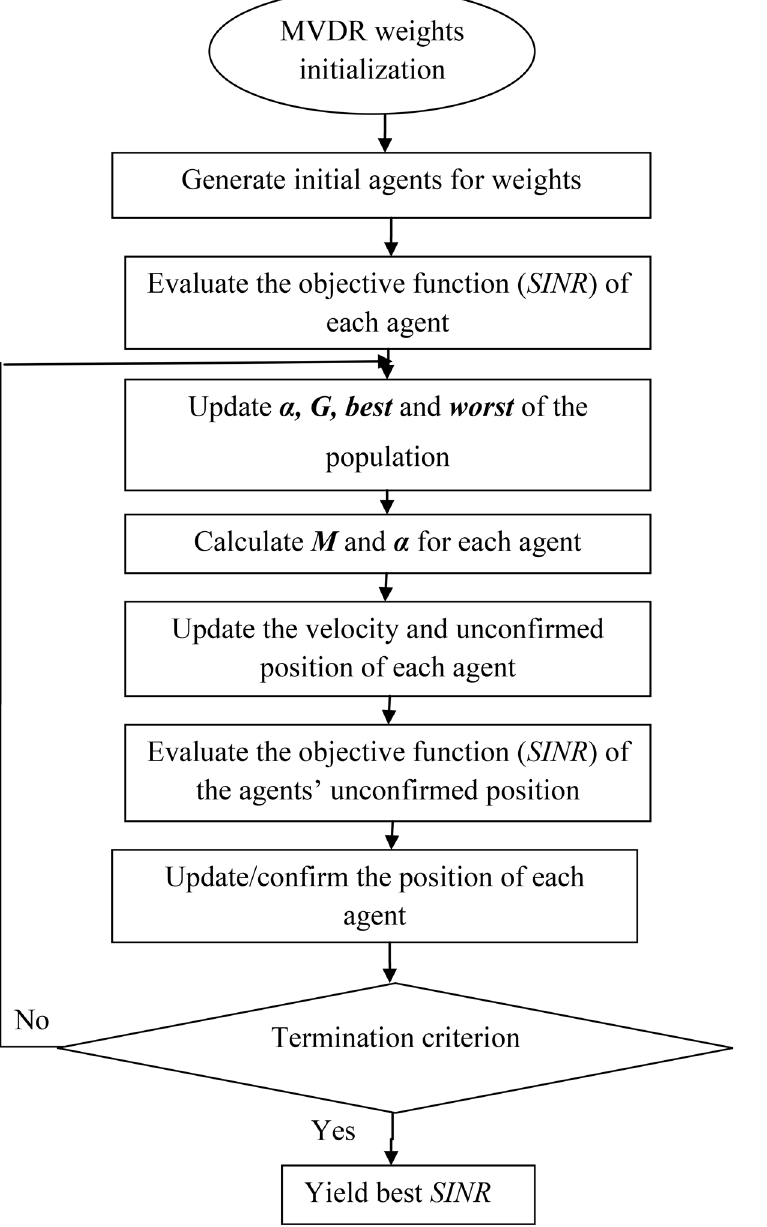
Fig 6. The simplified flowchart of ECGSA